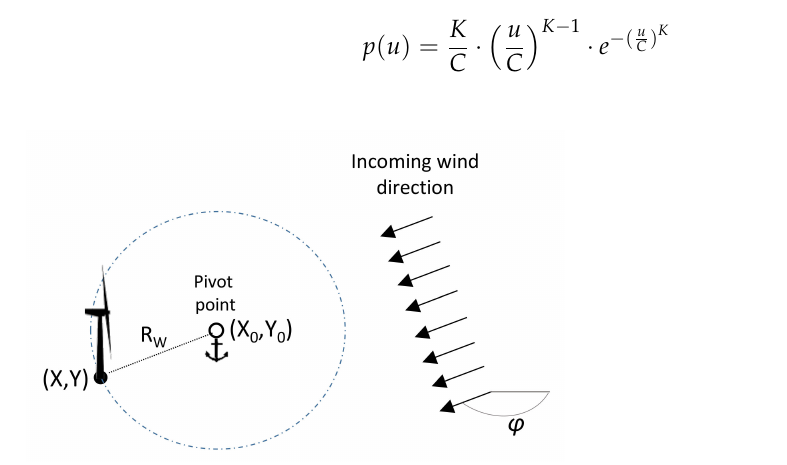
Figure 2. Schematic representation of the position of the wind turbines depending on the incoming wind